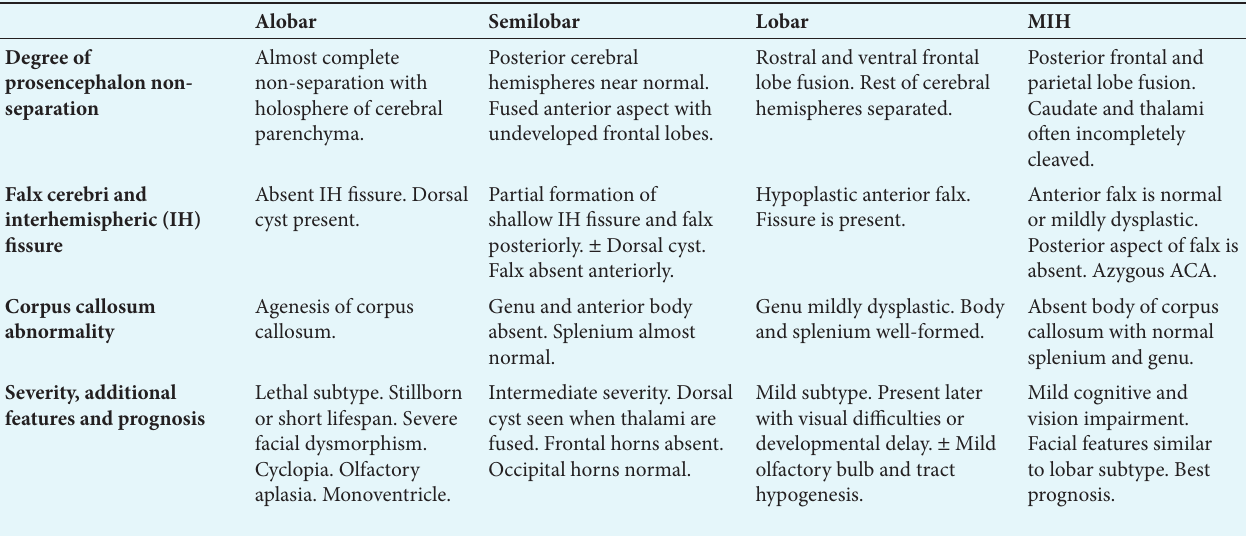
Table 1. Subtypes of holoprosencephaly and differentiating features